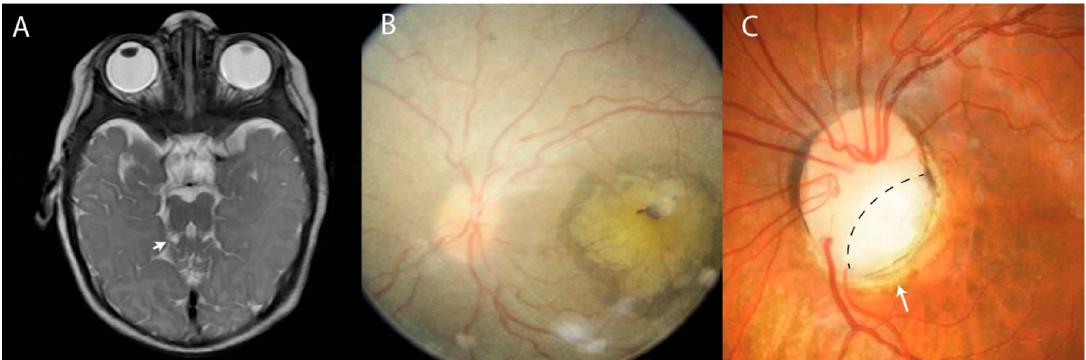
Figure 1. Representative clinical ocular presentations of Joubert Syndrome. ( A ) Magnetic resonance imaging (MRI) T2-weighted image of the “Molar Tooth Sign” (white arrow). ( B ) Retinal dystrophy with maculopathy. ( C ) Coloboma of the optic disc, marked with a dashed line.